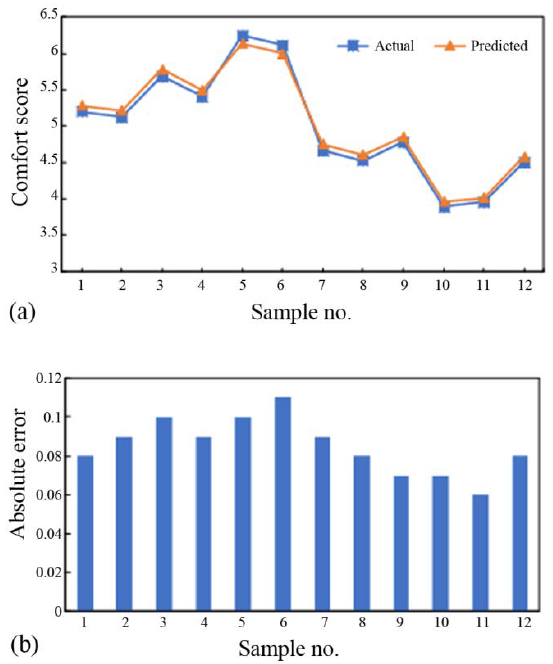
Figure 7. Prediction results of the IPSO-LSSVM algorithm. ( a ) Comparison of the actual values and predicted values. ( b ) Absolute error.